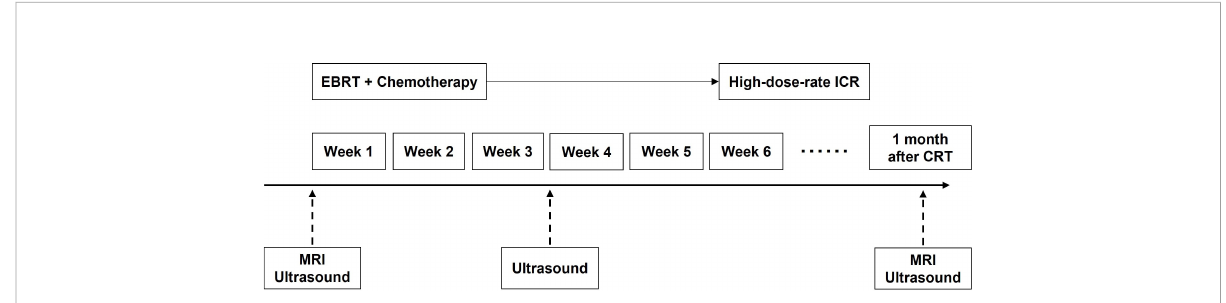
FIGURE 2 The schedule of MRI, TVUS examination and treatment. CRT, chemoradiotherapy; EBRT, external beam radiotherapy; ICR, intracavitary